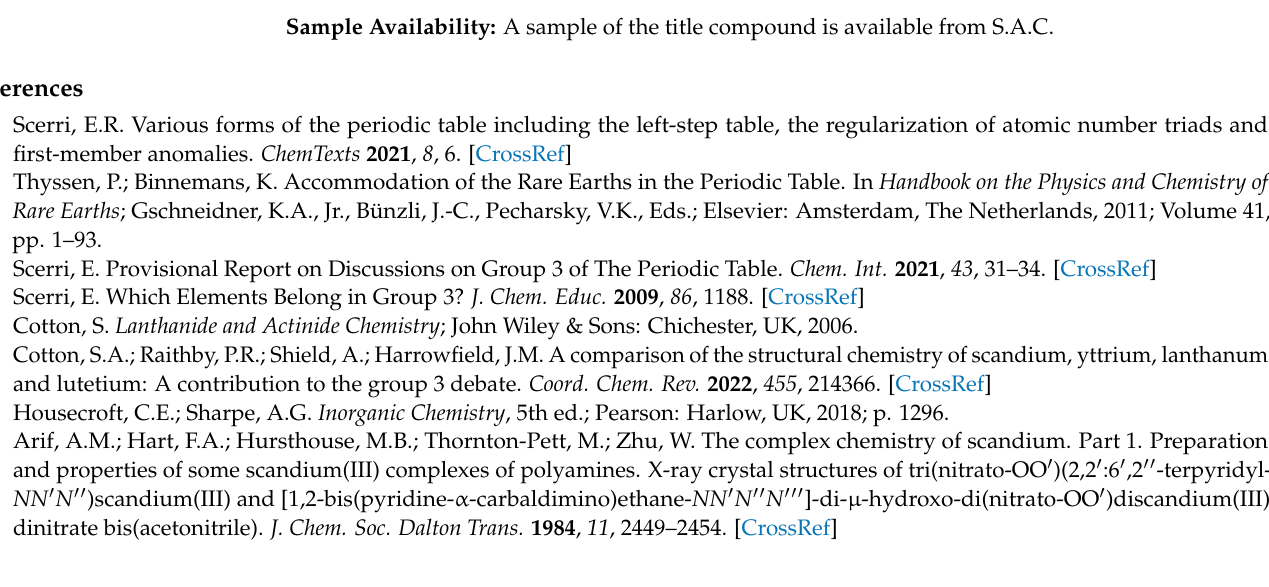
Table S4: Bond Lengths for bath333n; Table S5: Bond Angles for bath333n; Table S6: Hydrogen Bonds for bath333n; Table S7: Torsion Angles for bath333n; Table S8: Hydrogen Atom Coordinates (Å × 10 4 ) and Isotropic Displacement Parameters (Å 2 × 10 3 ) for bath333n; Figure S1: MALDI mass spectrum and solid state IR of the complex; Figure S2: Surface plot of D-norm surface-0_3117_1_0733; Figure S3: Fingerprint plot showing the presence of hydrogen bonding; Figure S4: Packing plot showing the H- hydrogen bonding interactions and the presence of the R2,2(12) rings. Supplementary crystallographic data (cif file) has been deposited at the Cambridge Crystallographic Data Centre (CCDC No: